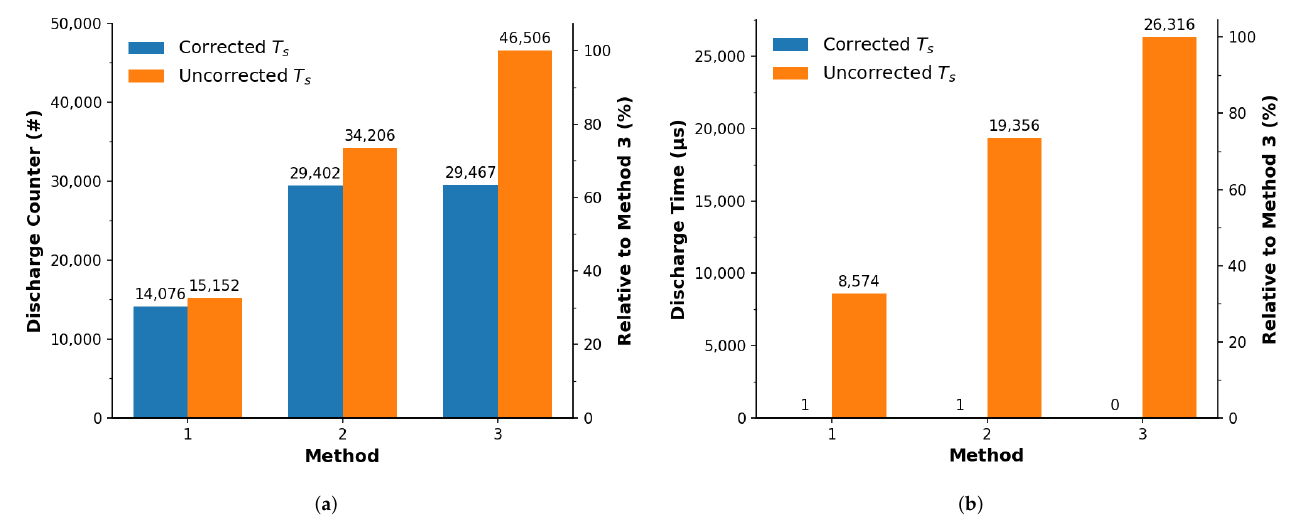
Figure 5. Comparison between the uncorrected and corrected T s approaches calculated from the data sets shown in Figure 4. ( a ) Discharge counter. ( b ) Discharge